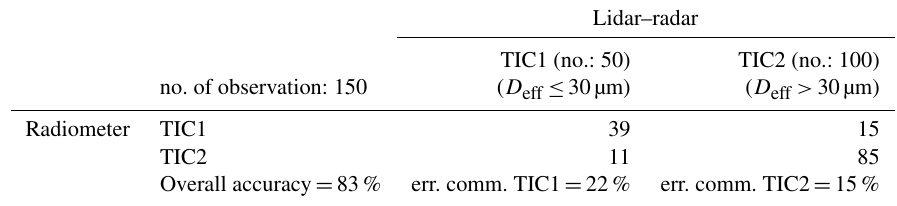
Figure 7. Radiometer-based retrieval results for (a) CODs compared with lidar derived CODs and (b) D eff compared with the lidar–radar retrieval product. The same comparisons, with MIXCRA retrievals being the reference, are shown in graphs (c) and (d) . The TIC1 results, because of the lidar–radar insensitivity of these small particles, are excluded from the scattergram but their D eff frequency distribution is shown in the inlaid histogram. The D eff comparisons with the MIXCRA retrievals show fewer points than the comparisons with the lidar– radar retrieval because the MIXCRA retrievals of D eff have relatively large uncertainties for cases where COD ≤ 0.2 (and thus are not shown). Table 3. Confusion matrix of the TIC1/TIC2 classification compared to lidar–radar retrievals. The term “err. comm.” stands for the error of